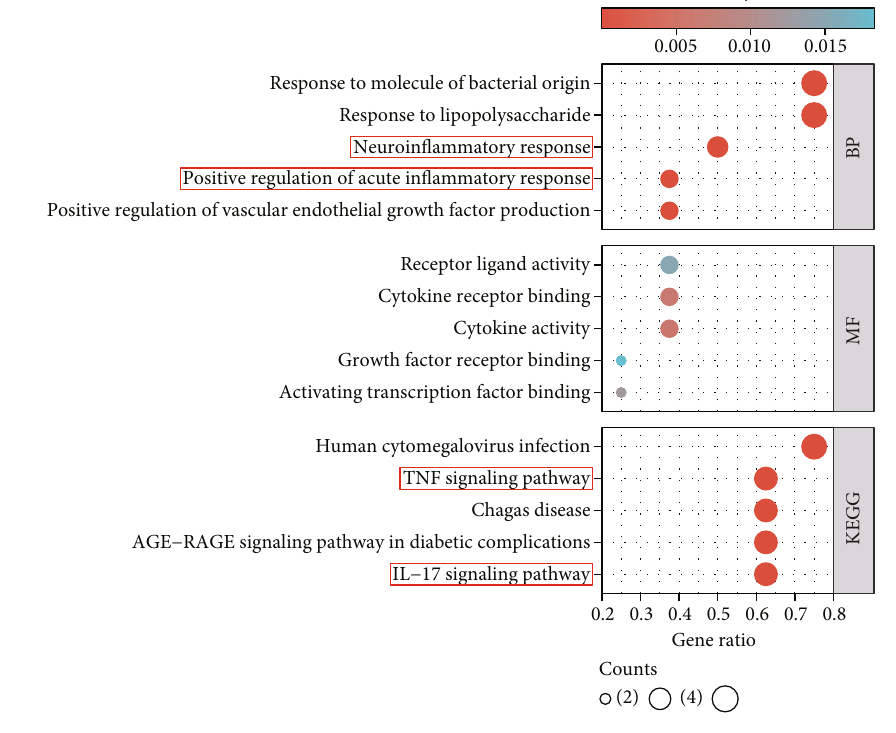
Figure 3: Enrichment analysis results (top